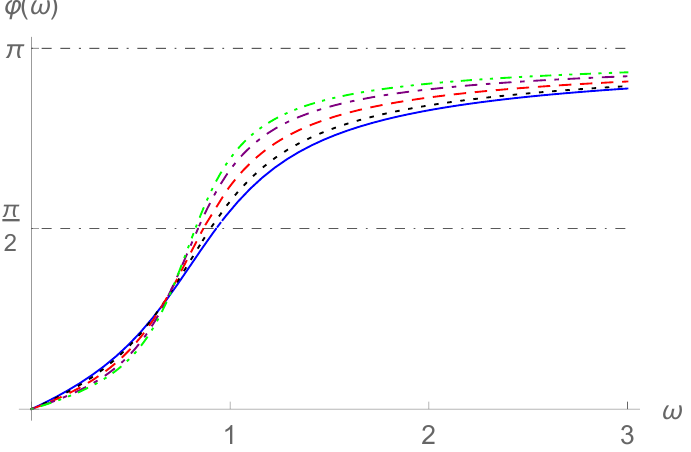
Figure 13. Frequency–phase curves ϕ ( ω ) for k = m = 1, c = 0.5, η = 0.5, and p = 0.01 (solid line), p = 0.1 (dotted line), p = 1 (dashed line), p = 10 (dot-dashed line), or p = 100 (dot-dot-dashed